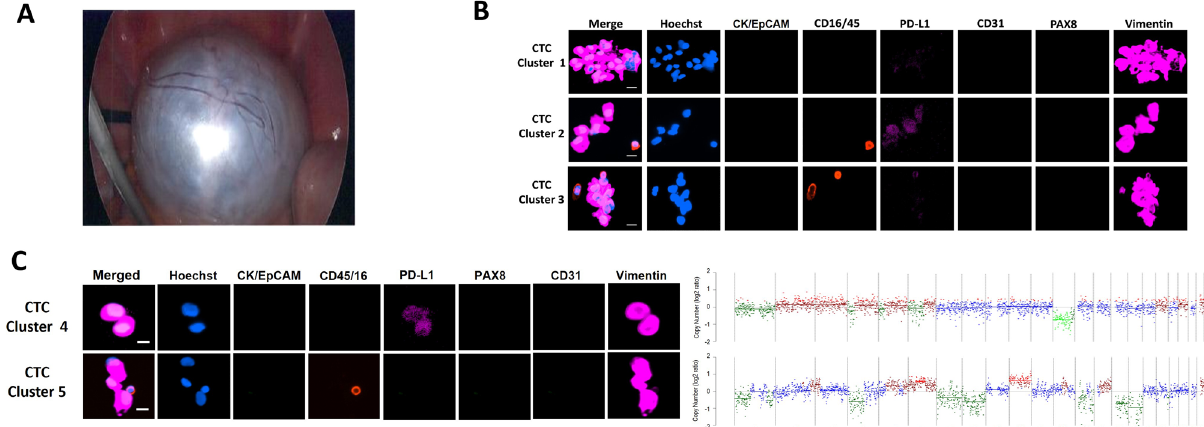
Figure 2. Representative fluorescence images of CTCs and their corresponding CNV profiles from the case with a benign tumour. Scale bar (bottom right) represents 10 μm. ( A ) T Photomicrograph of the tumour from the benign case, which was histologically diagnosed to be serous cystadenoma. Isolated cells ( B and C ) from blood were stained with antibodies for cytokeratin and EpCAM and cytokeratin (FITC, green), CD45/CD16 (PE, red), PDL1 (AF647, cyan) and nuclei staining in blue (Hoechst), in the first panel. It was followed by fluorescence quenching and re-staining with antibodies for PAX8 (FITC, green), CD31 (PE, red) and vimentin (AF647, cyan). Detected cells were mainly vimentin positive clusters. ( C ) CNA profiles obtained from low-pass whole-genome sequencing are shown at the far right from randomly selected clusters. Blue dots indicate neutral CNA, red indicate gains, and green indicate